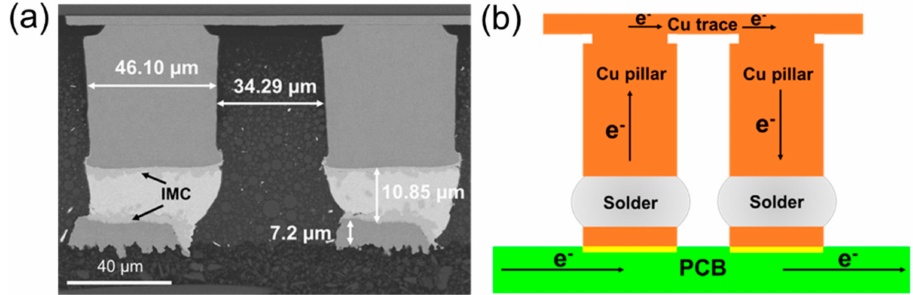
Figure 1. The structure of tested copper pillar joint: ( a ) The dimension and structure of the test samples after reflow; ( b ) the schematic diagram of experiment